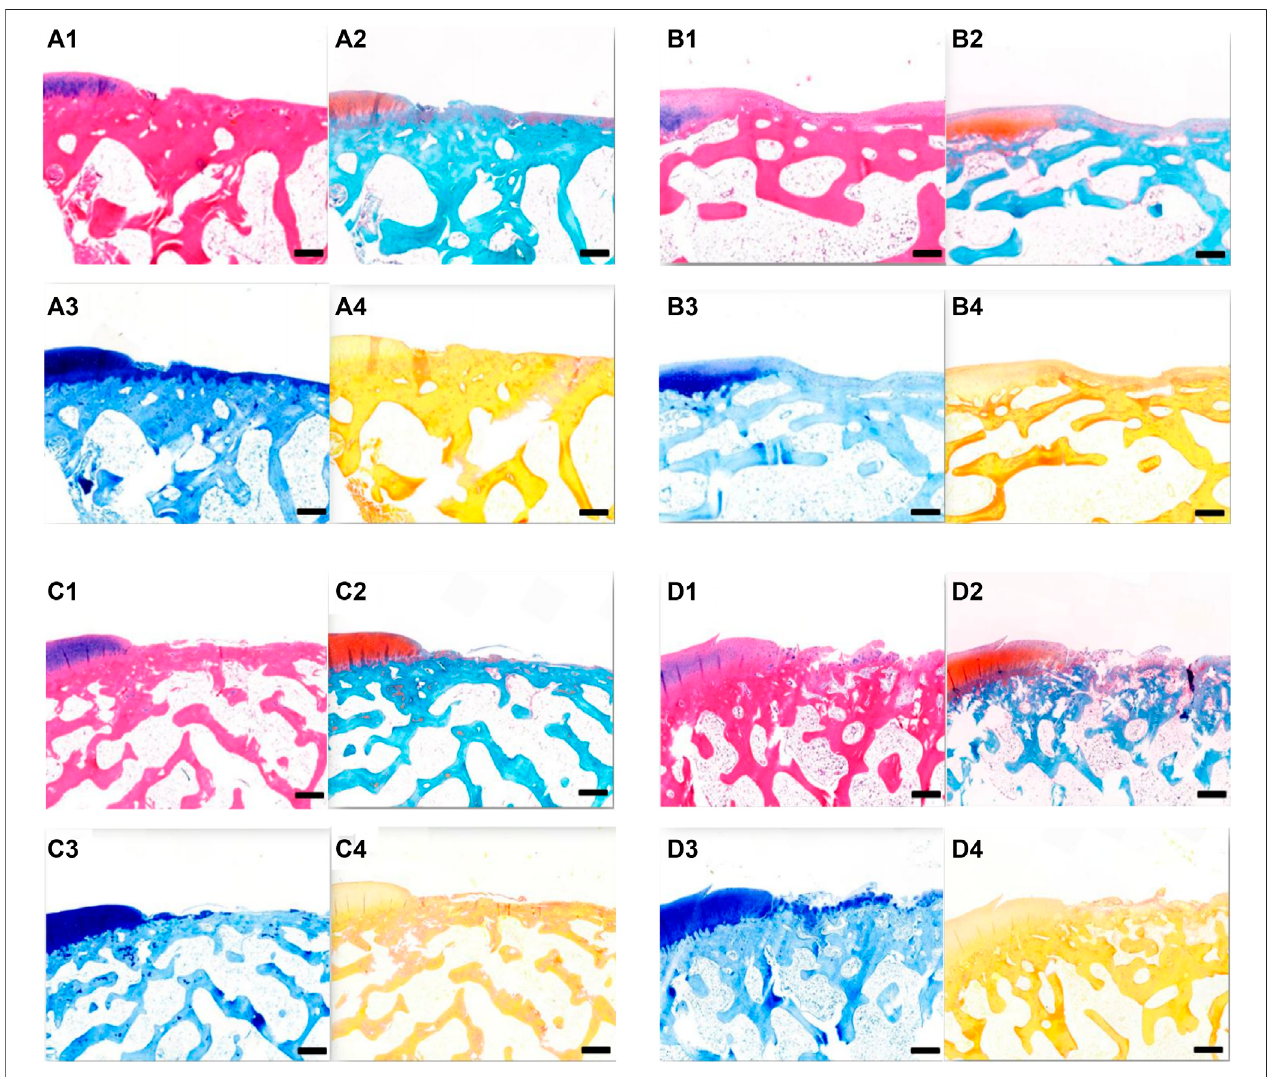
FIGURE 10 | (A) Tissue section of group A at 6 weeks after operation. (A1) HE staining; (A2) Safranin-O/fast green staining; A3 . Toluidine blue dyeing; A4 . Sirius red staining. Scale = 1 mm. (B) Tissue section of group B at 6 weeks after operation. B1 HE staining; B2 Safranin-O/fast green staining; B3 toluidine blue dyeing; B4 Sirius red staining. Scale = 1 mm. (C) Tissue section of group C at 6 weeks after operation. C1 HE staining; C2 Safranin-O/fast green staining; C3 toluidine blue dyeing; and C4 Siriusredstaining.Scale=1 mm. (D) Tissuesection ofgroupDat 6 weeksafter operation. D1 HE staining; D2 Safranin-O/fastgreenstaining; D3 toluidine blue dyeing; and D4 Sirius red staining. Scale = 1